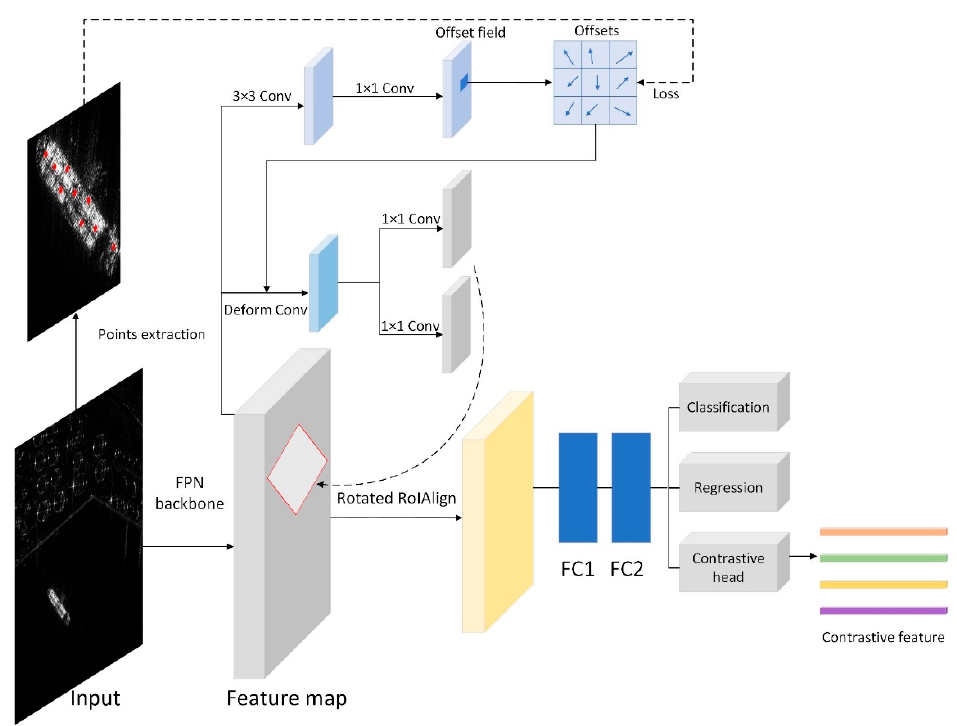
Figure 2. Overall framework of the proposed detector. It consists of the backbone, the FPN, the scattering-point-guided RPN, the Rotated RoIAlign, and the contrastive head.